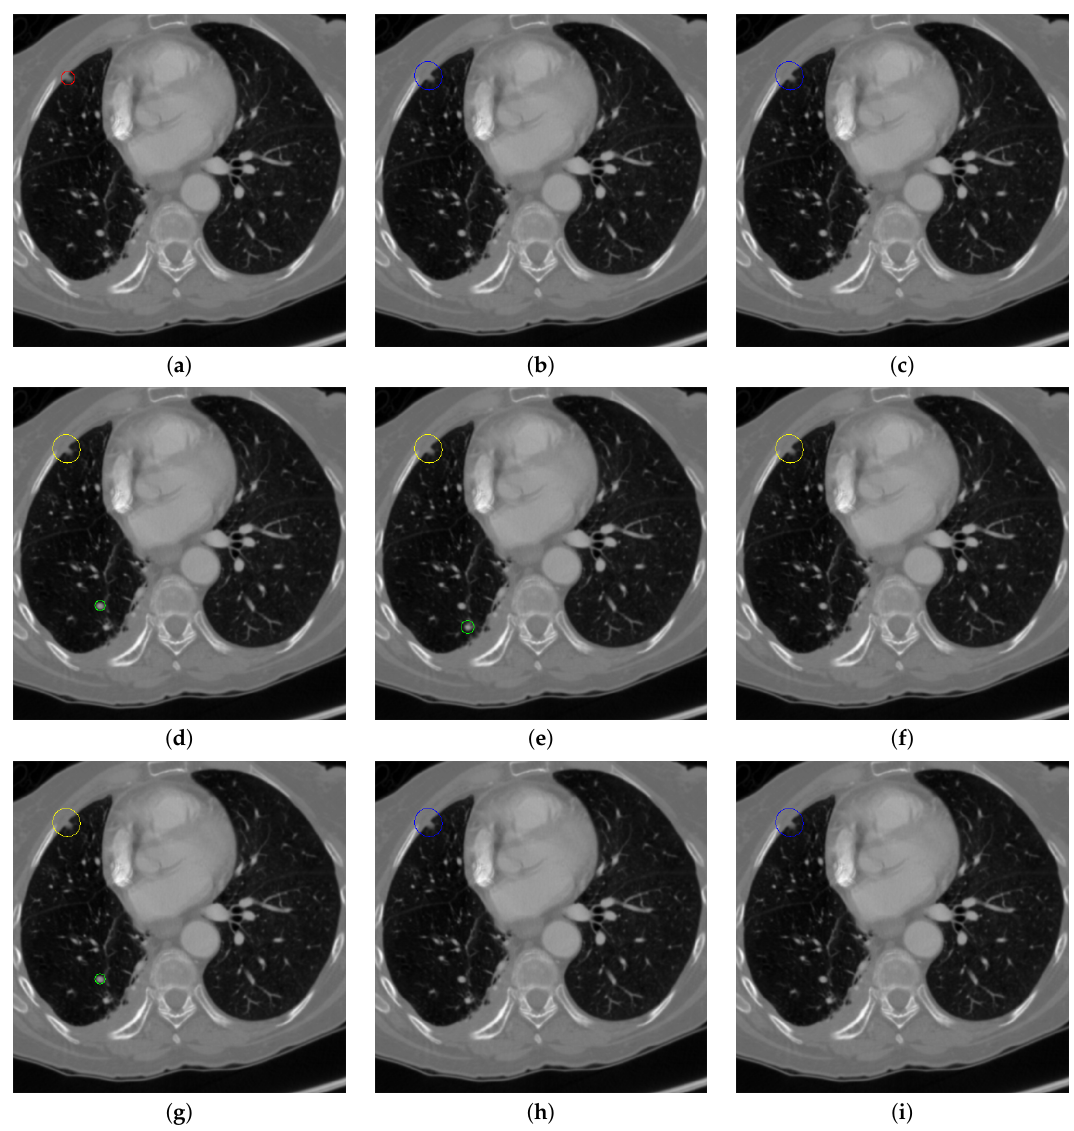
Figure 20. The result of detecting pulmonary nodules by different methods on another example image in TianChi dataset. Red circle represents the ground truth region of nodules, blue circles represent the correct estimation of pulmonary nodules, green circles represent the over-detected nodules, while yellow circles denote the nodules being omitted. ( a – i ) are: ground truth nodule in the given chest CT image, nodule detected by 3D-FCN, MR-CNN, 3D-UNET, PRN-HSN, DCNN, CLAHE-SVM, MASK-RCNN and our proposed